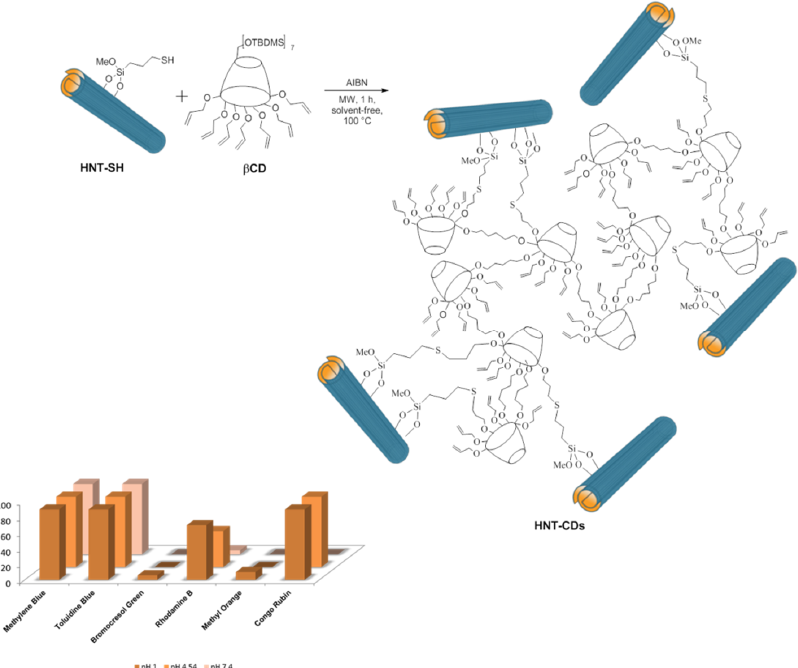
Figure 16. Schematic representation of the synthesis of HNTs and cyclo-desxtrin nanocomposite as adsorbent for organic dyes. Adapted with permission from [143].